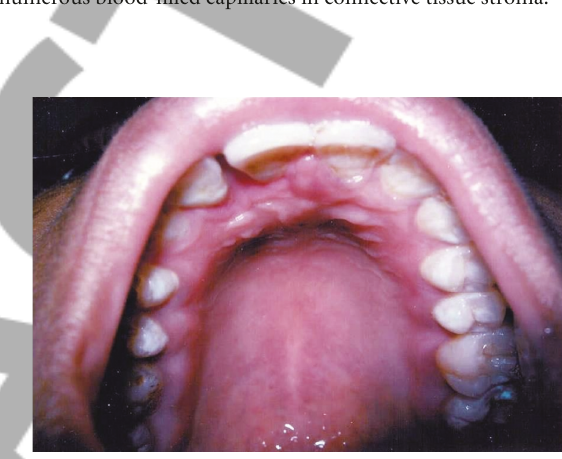
Figure 3: Postoperative view after one